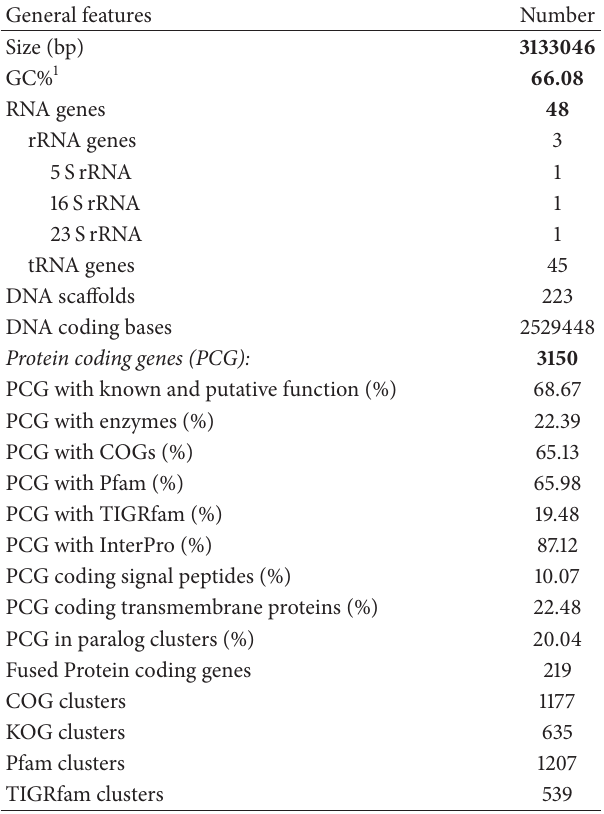
Table 1: General features of the H. hamelinensis